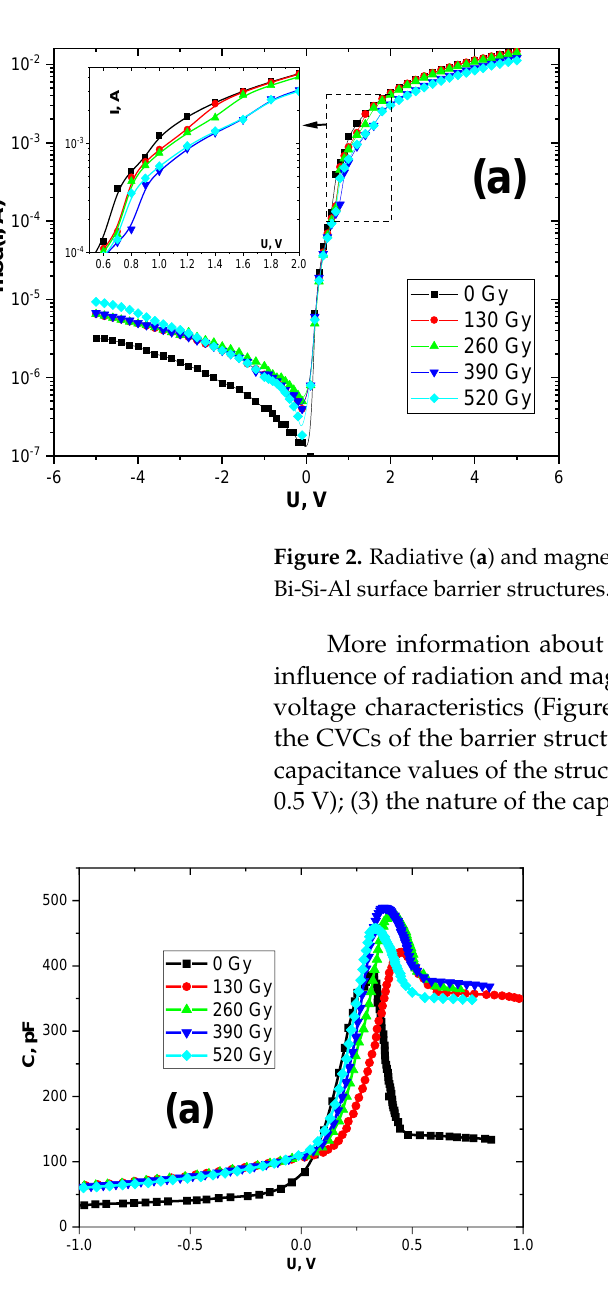
Figure 3. Radiative ( a ) and magnetic ( b ) stimulated changes of capacitance–voltage characteristics in the Bi-Si-Al surface barrier structures.